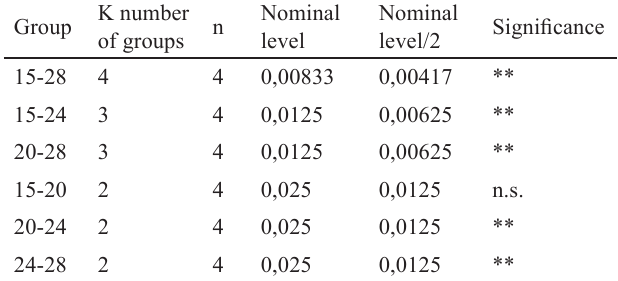
Table 2 . Summary of multiple comparisons of variances at 5% level